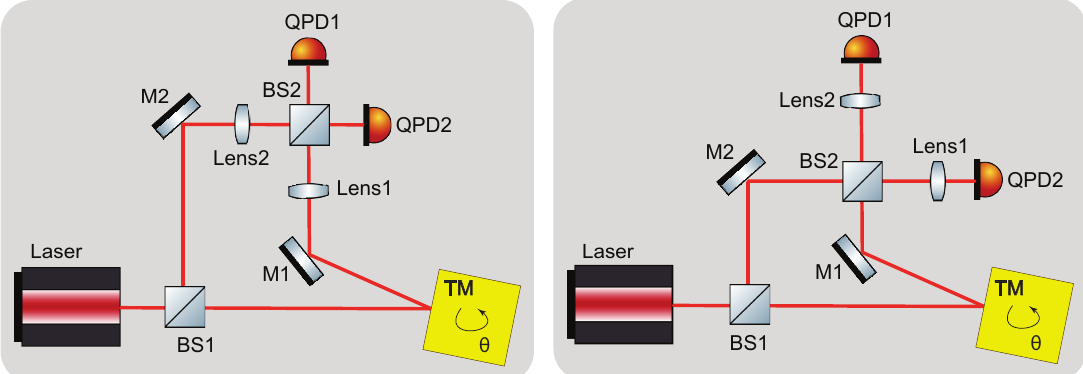
Figure 1. Possible positioning of the lenses in the interferometer setup with the test-mass (TM) in nominal position. ( Left ) lenses implemented before beam-splitter BS2; ( Right ) lenses implemented after BS2. The interferometric signals on the two quadrant photo diodes (QPD) are symmetric, therefore one of them can be considered as a